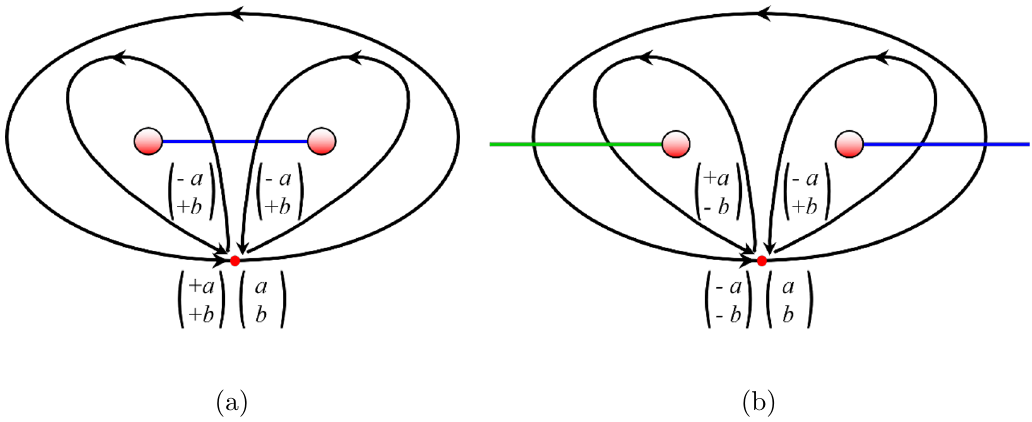
Figure 4 . Configurations of two strings classified by AB phases around the strings. Configurations of two strings can be classified into either (a) the confinement or (b) the decay, depending on AB phases of the doublet field encircling around the strings. (a) When the doublet field Ψ = ( a, b ) T encircles the right (left) string along a smaller loop, it becomes Ψ = ( − a, b ) T which is not single- valued if there is no AB defect, implying the existence of an AB defect attached to each of them. When the doublet field Ψ = ( a, b ) T encircles the both strings together (along the large loop), it comes back to Ψ = ( a, b ) T which is single-valued, implying the absence of AB defect crossing the large loop. Therefore, one AB defect connects the two strings, corresponding to the confinement. (b) When the doublet field Ψ = ( a, b ) T encircles the right (left) string, it becomes Ψ = ( − a, b ) T ( Ψ = ( a, − b ) T ) which is not single-valued if there is no AB defect, implying the existence of a different AB defect attached to each of them. When the doublet field Ψ = ( a, b ) T encircles the both strings together (along the large loop), it becomes Ψ = ( − a, − b ) T which is not yet single-valued, implying the existence of the two kinds of AB defects crossing the large loop. No AB defect connects the two strings, corresponding to the